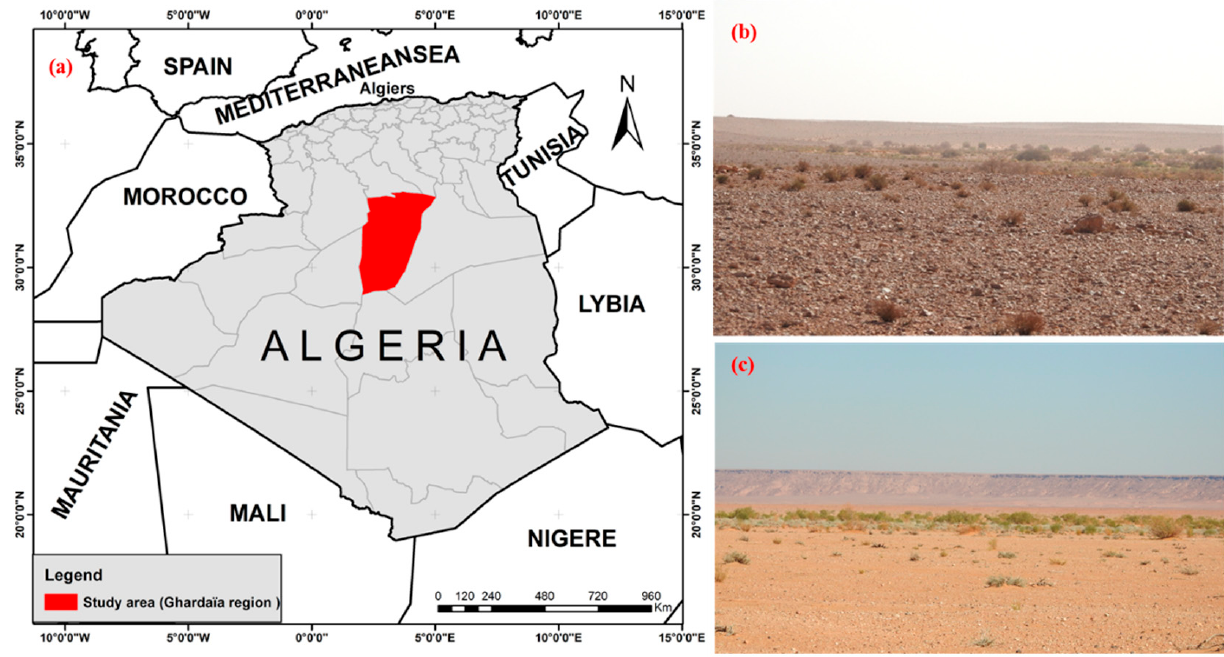
Figure 1. Study area. ( a ) Map of Algeria showing the Ghardaïa region; ( b ) reg formations and “desert pavement”; ( c ) wadi bed.